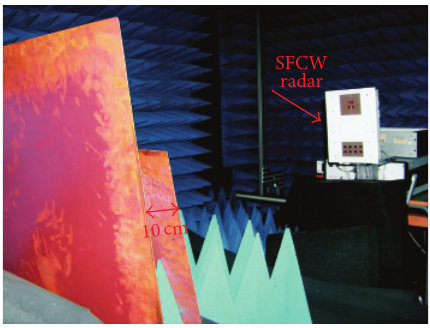
Figure 12: Test setup into the Microwave Laboratory at University of Calabria.